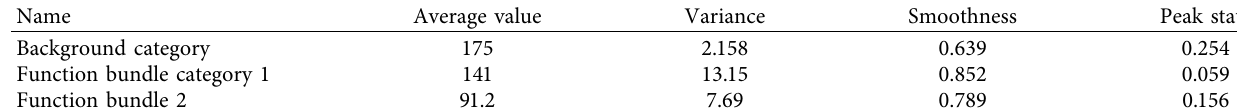
Table 3: Image enhancement metrics for different regions.